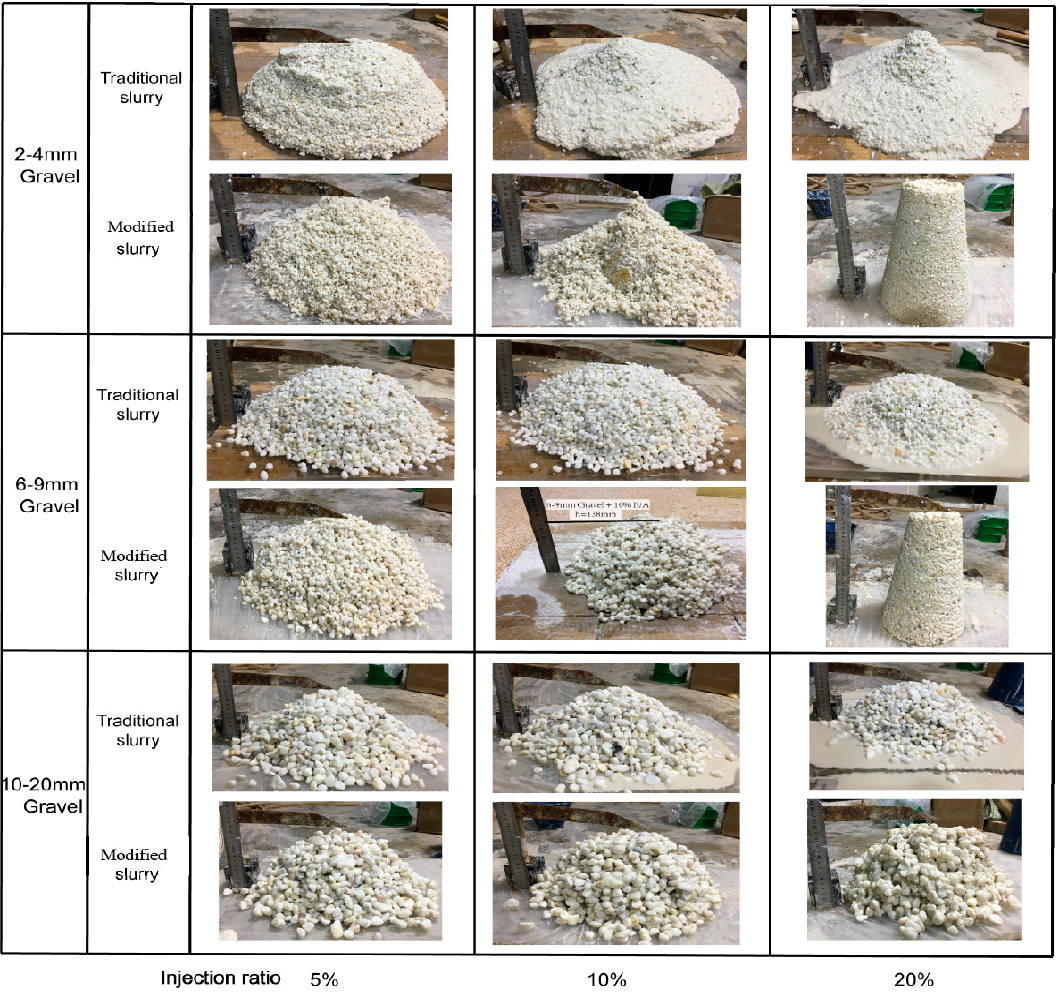
Figure 5. Comparison of slump between traditional slurry and B/A modified slurry at various injection ratios.